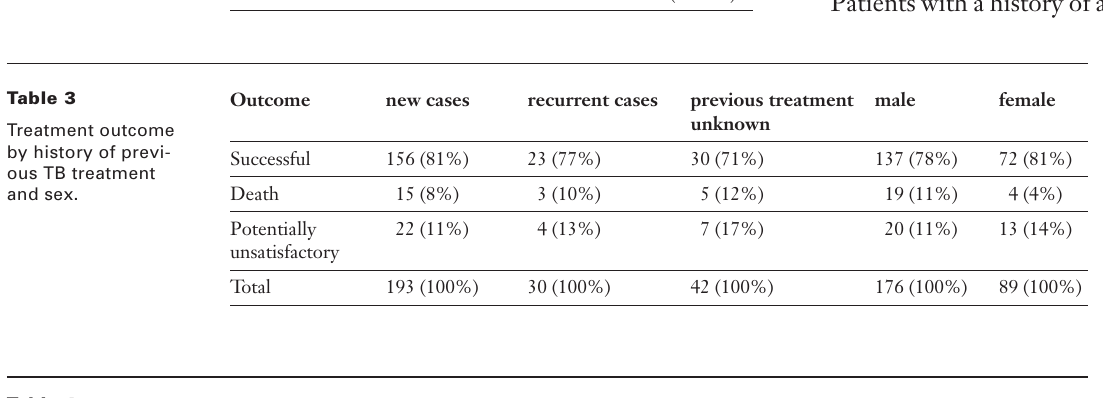
Outcome by age (quartiles of age